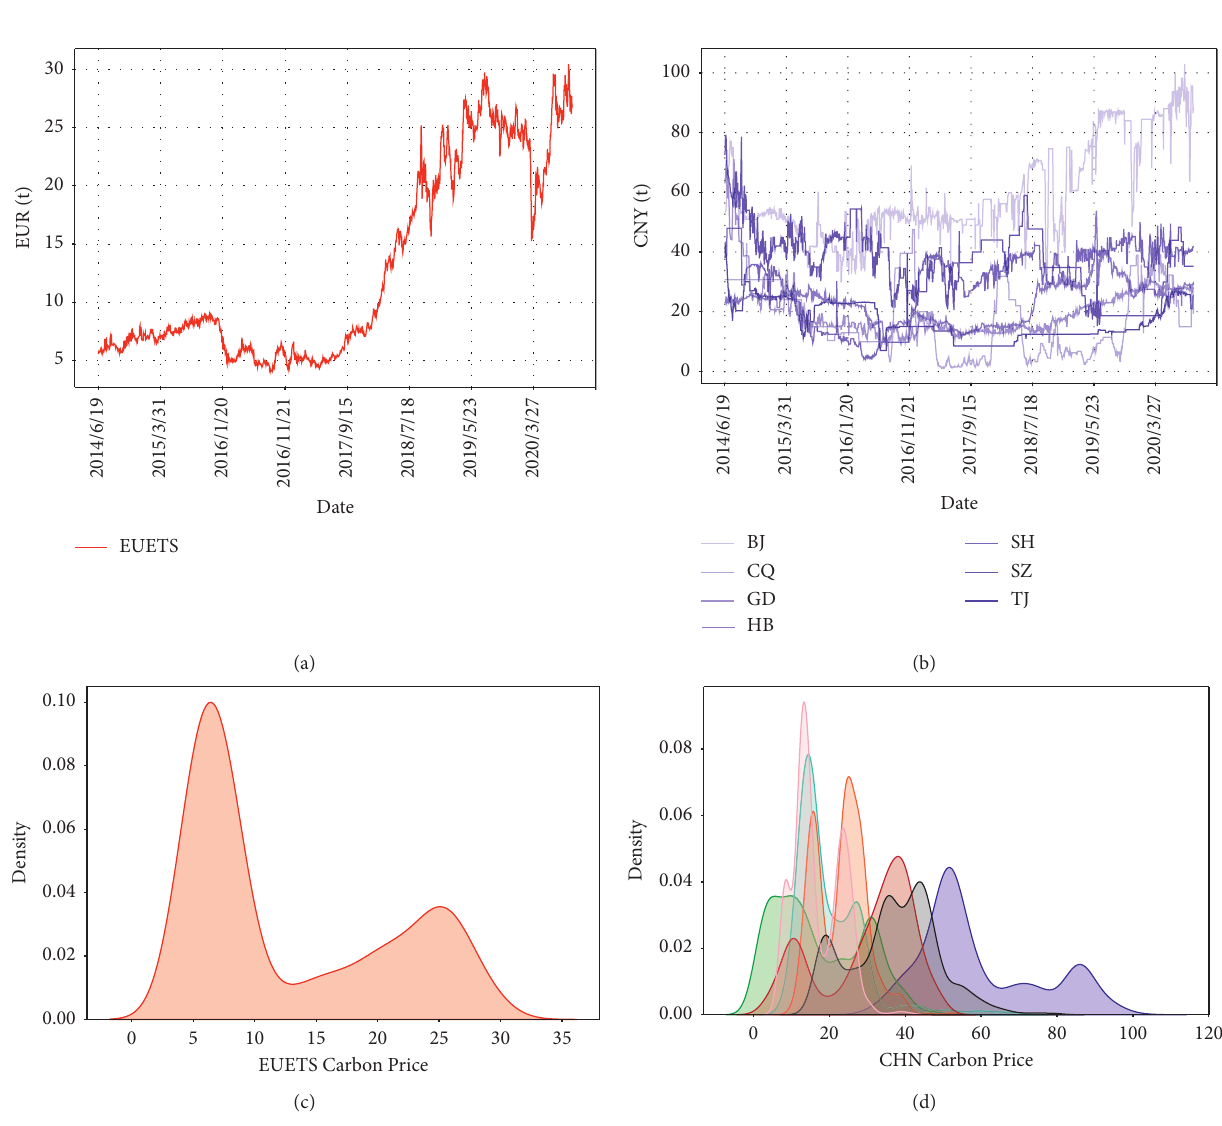
Figure 2: Sample data of carbon prices and their descriptive